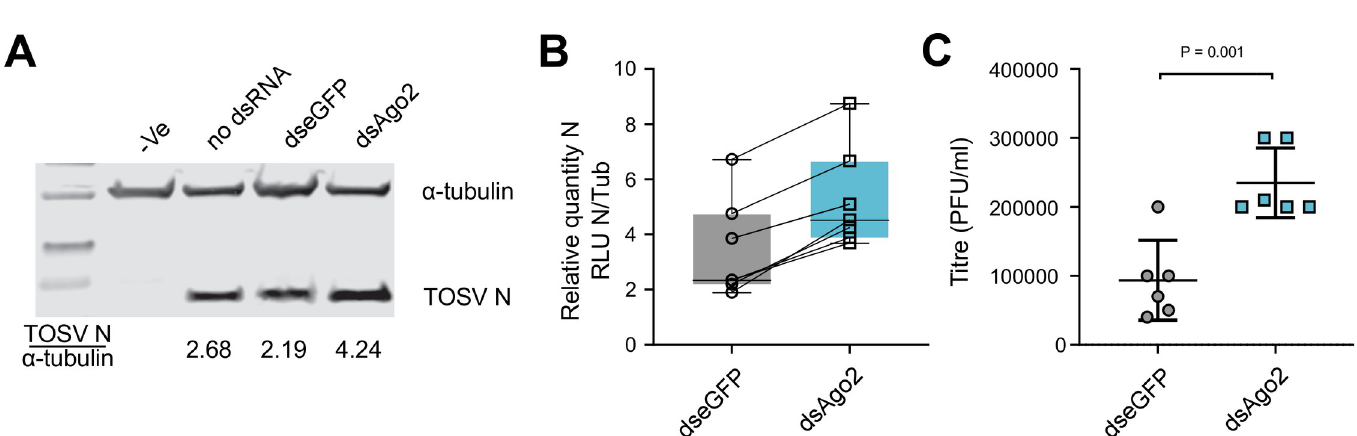
Fig 6. Depletion of Ago2 in rTOSV-infected PP9ad cell cultures leads to an increase in virus replication. PP9ad cells were either mock transfected or transfected with 100 ng of dseGFP or dsAgo2 for 24 h before being infected with rTOSV at a MOI of 10 PFU/cell. At 48 h.p.i., cells were harvested. (A-B) Cell lysates were probed with anti-TOSV N and anti- α -tubulin antibodies, the ratio of TOSV N RLU: α -tubulin RLU was calculated and presented for the dseGFP and dsAgo2 samples. (C) Viral titres in cell culture supernatants were titrated by plaque assay. Data analysed by unpaired t-test, P = 0.001 (C). Figure shows data from seven independent blots (B) and six independent infections for titrations (C), data are presented as the mean value ± SD.